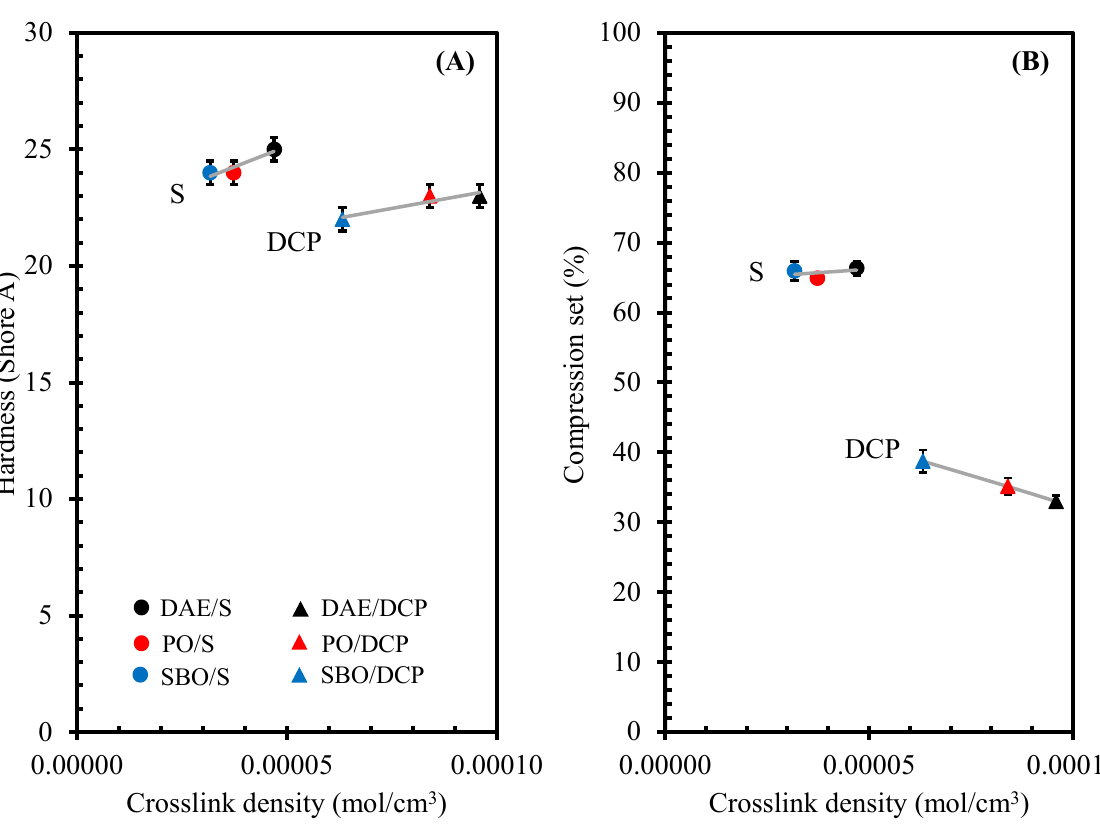
Figure 12. Hardness ( A ) and compression set ( B ) as a function of crosslink density of NR compounds containing different types of oils and cured by various curing systems.